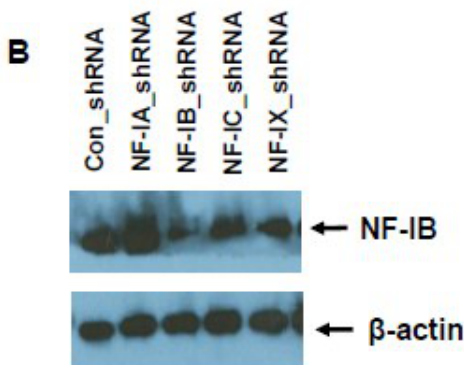
Figure 6. ( A ) HIV-1 infection in NF-IB knock-down PBMCs. shNF-IB or sh-control selected PBMCs were infected with HIV-1 for 10 days. On day 3, 6, and 10 post-HIV-1 infection, cells were tested for the HIV-1 gag levels using quantitative PCR. The data represent the mean ± SEM from three experiments . ( B ). Knock-down of NF-I family members in PBMCs. PBMCs were used to knock-down NF-I family members expression levels using MISSION Lentiviral Transduction Particles. Reduction in the NF-IB protein expression was measured by Western blot. Beta-actin was used as internal control. * p ≤ 0.05 compared to control shRNA treated cells. The data presented are a relative fold change compared to control shRNA treated cells at each time